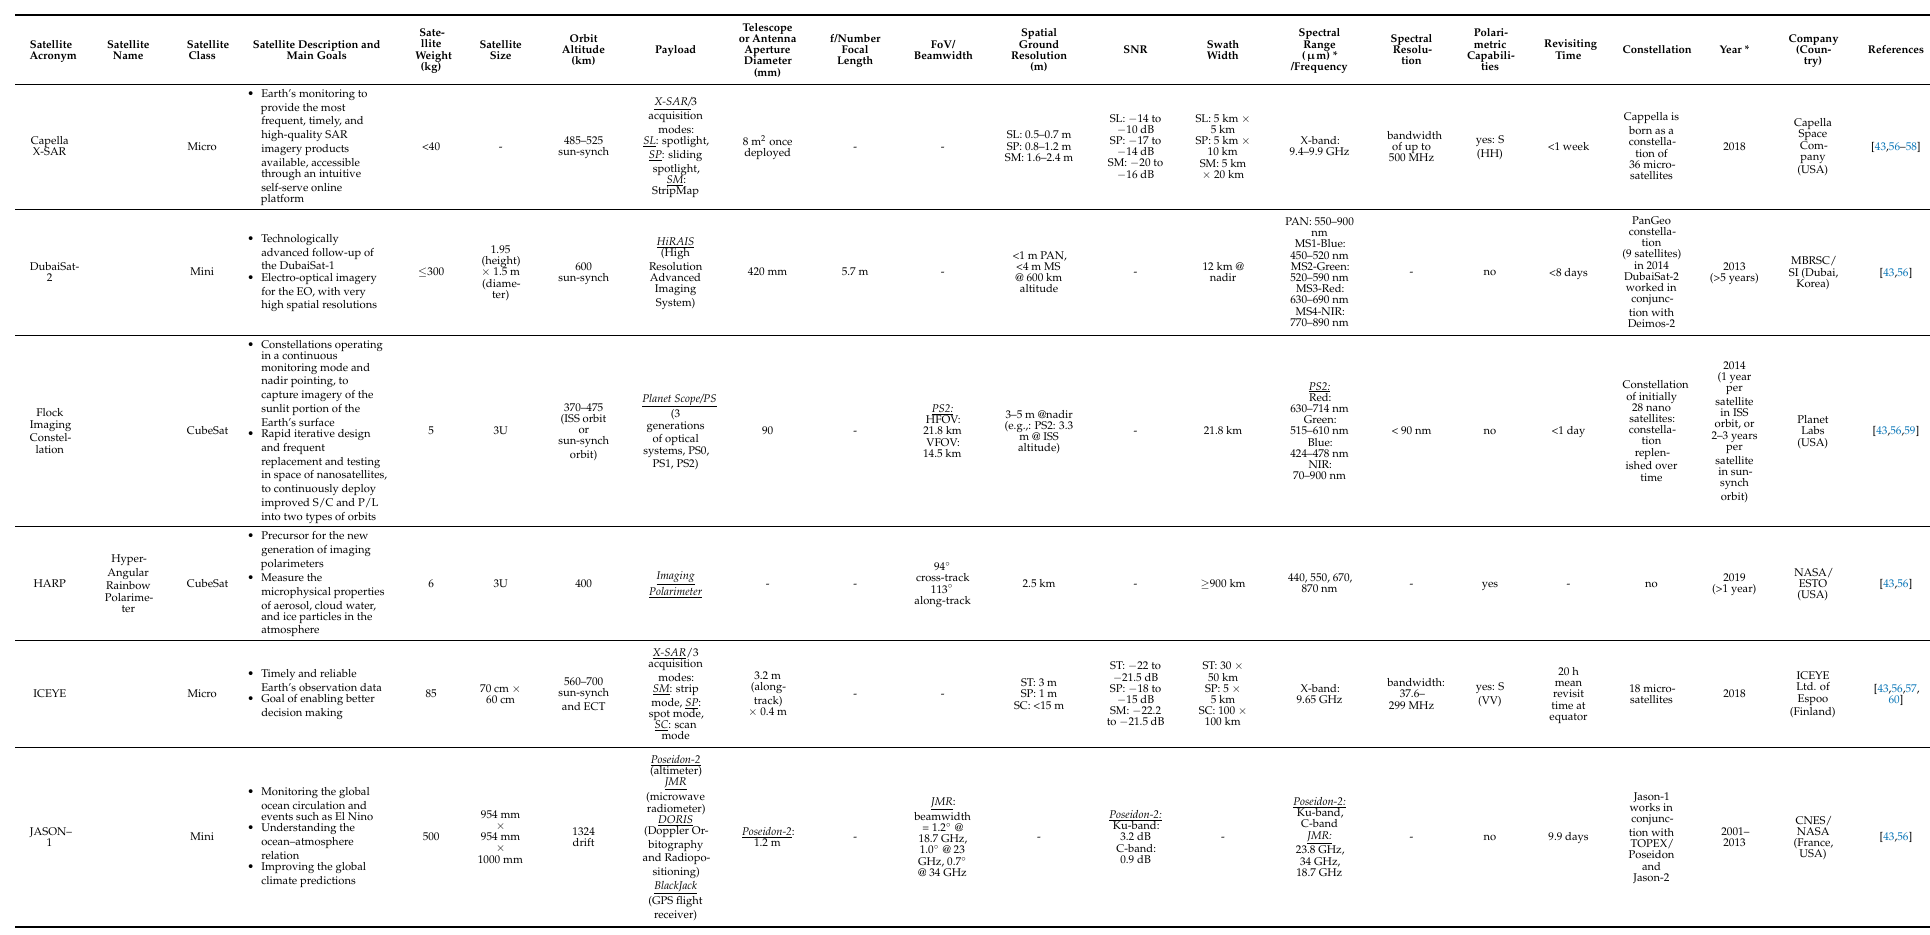
Table 2. List of the small satellites used in the text, with their main